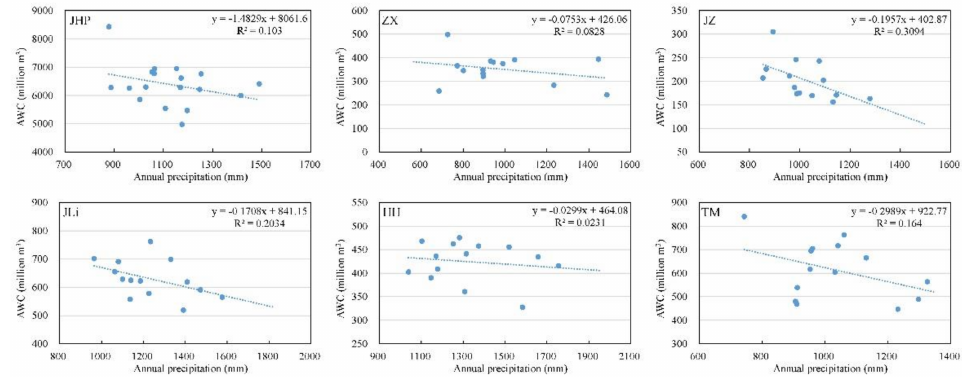
Figure 8. Correlations between annual precipitation and AWC in JHP and its